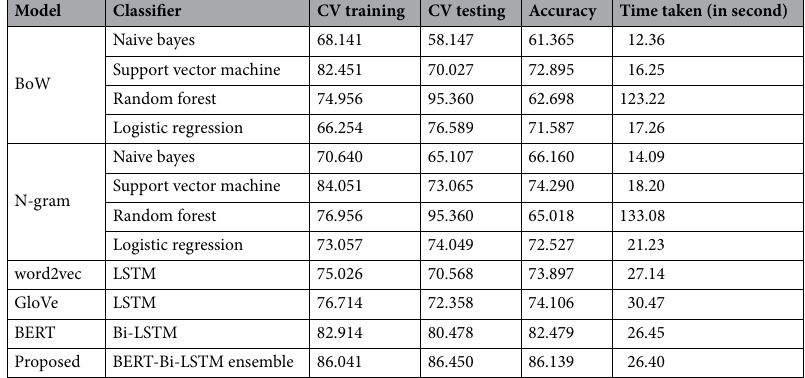
Table 5. Proposed model comparison with baseline method on the Covid-19 dataset.